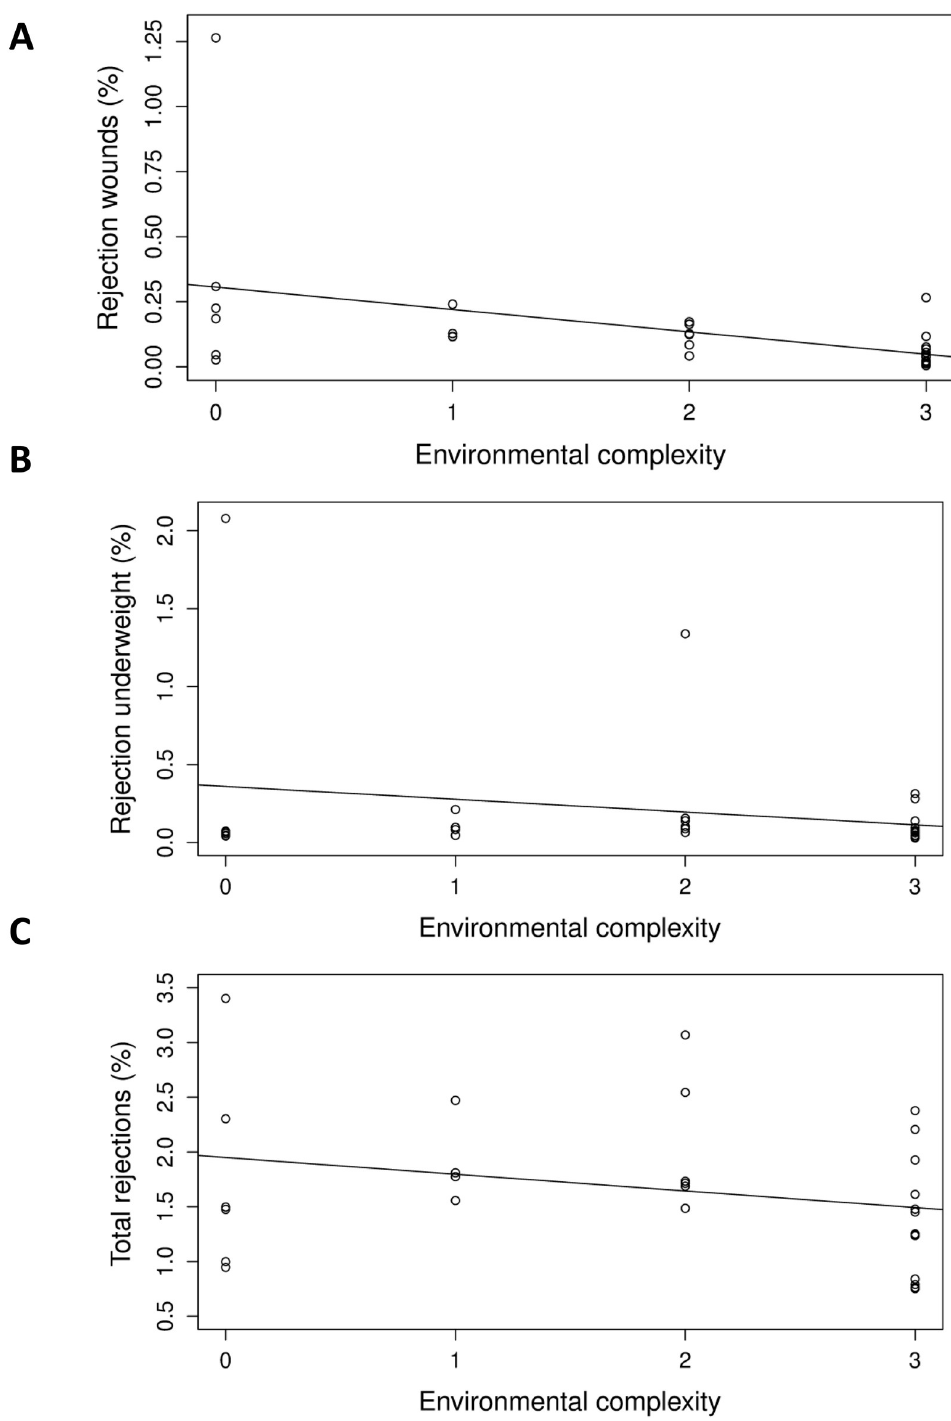
Fig 2. Associations of environmental complexity with rejections due to (A) wounds (r 2 = 0.206), and (B) underweight birds (r 2 = 0.053), and (C) total rejections (r 2 = 0.076). Environmental complexity is based on the number of environmental enrichment types (boxes, peat, wood shavings bales) provided (from 0–3). Data points are back-transformed estimates. (A, B, C) Carcasses rejected as a % of total number of slaughtered birds.